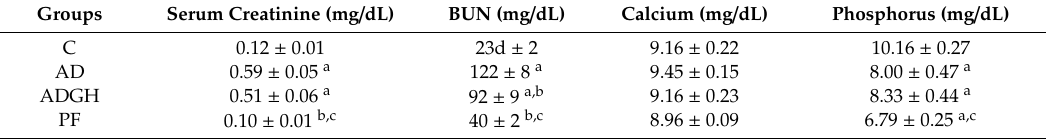
Table 1. Serum biochemical determinations in the four groups of rats ( n ≥ 5 per group).